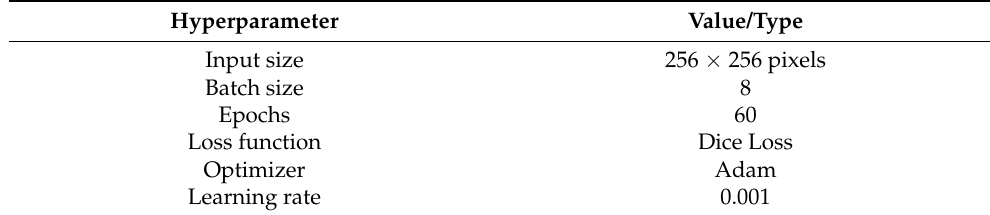
Table 5. Hyperparameters for model training.